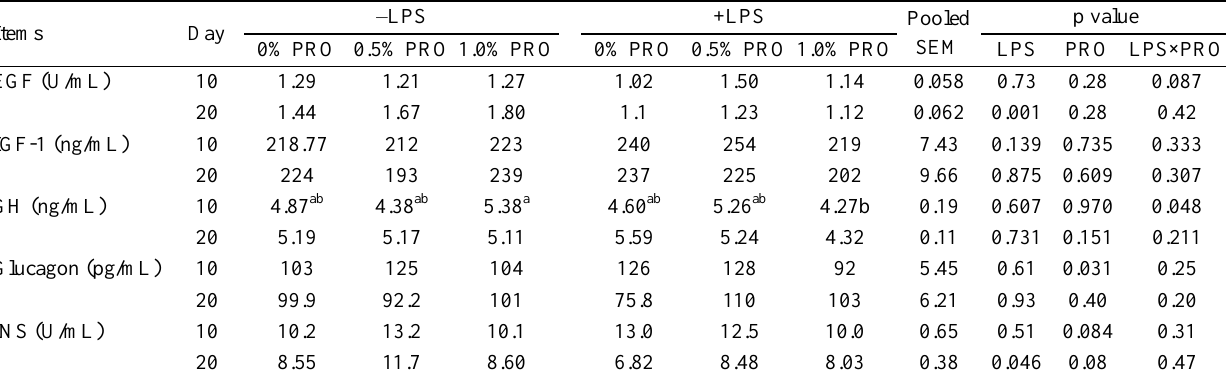
Table 4. Effects of L-proline supplementation on hormone concentrations in plasma of weanling piglets after LPS challenge (10-20 d) 1